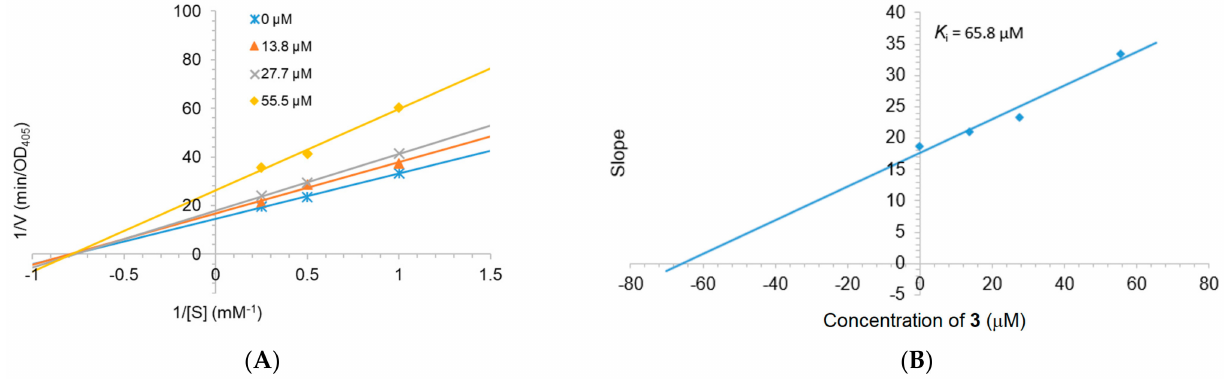
Figure 4. Lineweaver–Burk plot for alpha-glucosidase inhibition by 3 ( A ) and the secondary plot of slope vs. the inhibitor concentration ( B